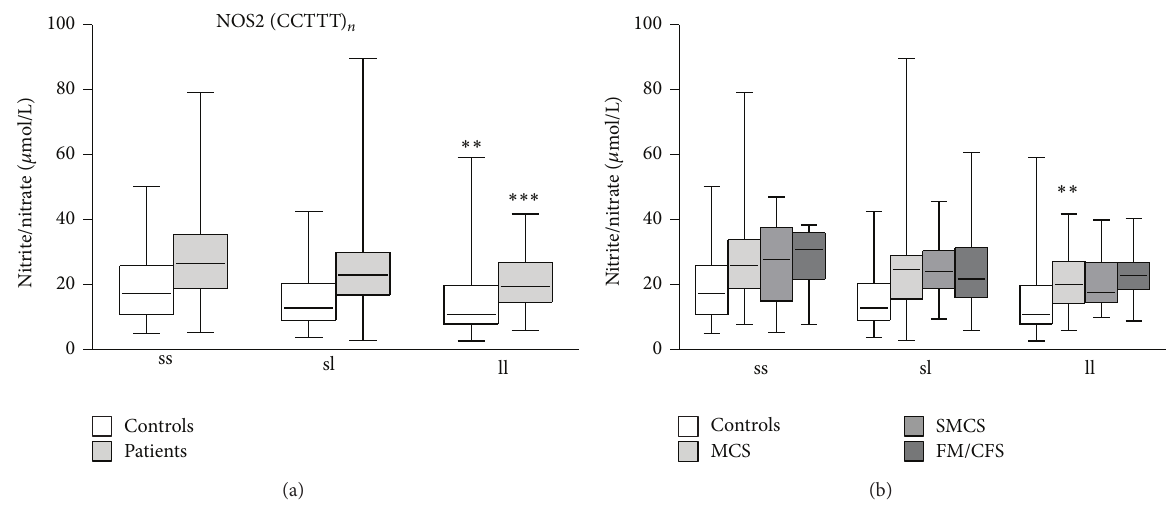
Figure 3: Effects of different NOS2 − 2.5kb (CCTTT) 𝑛 short (s) versus long (l) repeats alleles on nitrite/nitrate plasma levels in IEI patients (MCS = 170; SMCS = 108; FM/CFS = 89), grouped together (a) or separated (b), and controls ( 𝑁 = 196 ). Box-plots graphically depict the variation in plasma nitrite/nitrate concentrations of patients and healthy subjects, having different NOS2 − 2.5 kb (CCTTT) 𝑛 genotypes, through their quartiles. The bottom and top of the boxes are the first and third quartiles, and the band inside the boxes is the second quartile (the median); lines extending vertically from the boxes (whiskers) indicate variability outside the upper and lower quartiles (the ends of the whiskers represent the minimum and maximum of all of the data). (a) ∗∗ 𝑃 < 0.01 , ∗∗∗ 𝑃 < 0.001 significant difference versus subjects with /( CCTTT ) ( CCTTT ) genotype; (b) ∗∗ 𝑃 < 0.01 , significant difference versus MCS with ( CCTTT ) s s